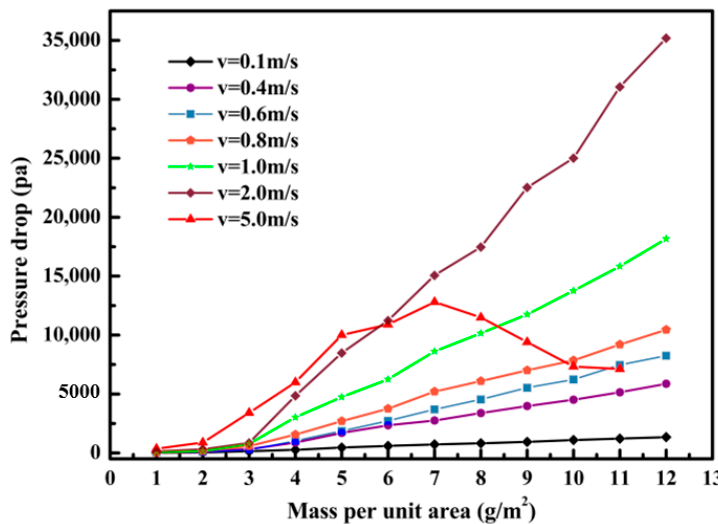
Figure 15. Influence of inlet velocity on pressure drop.